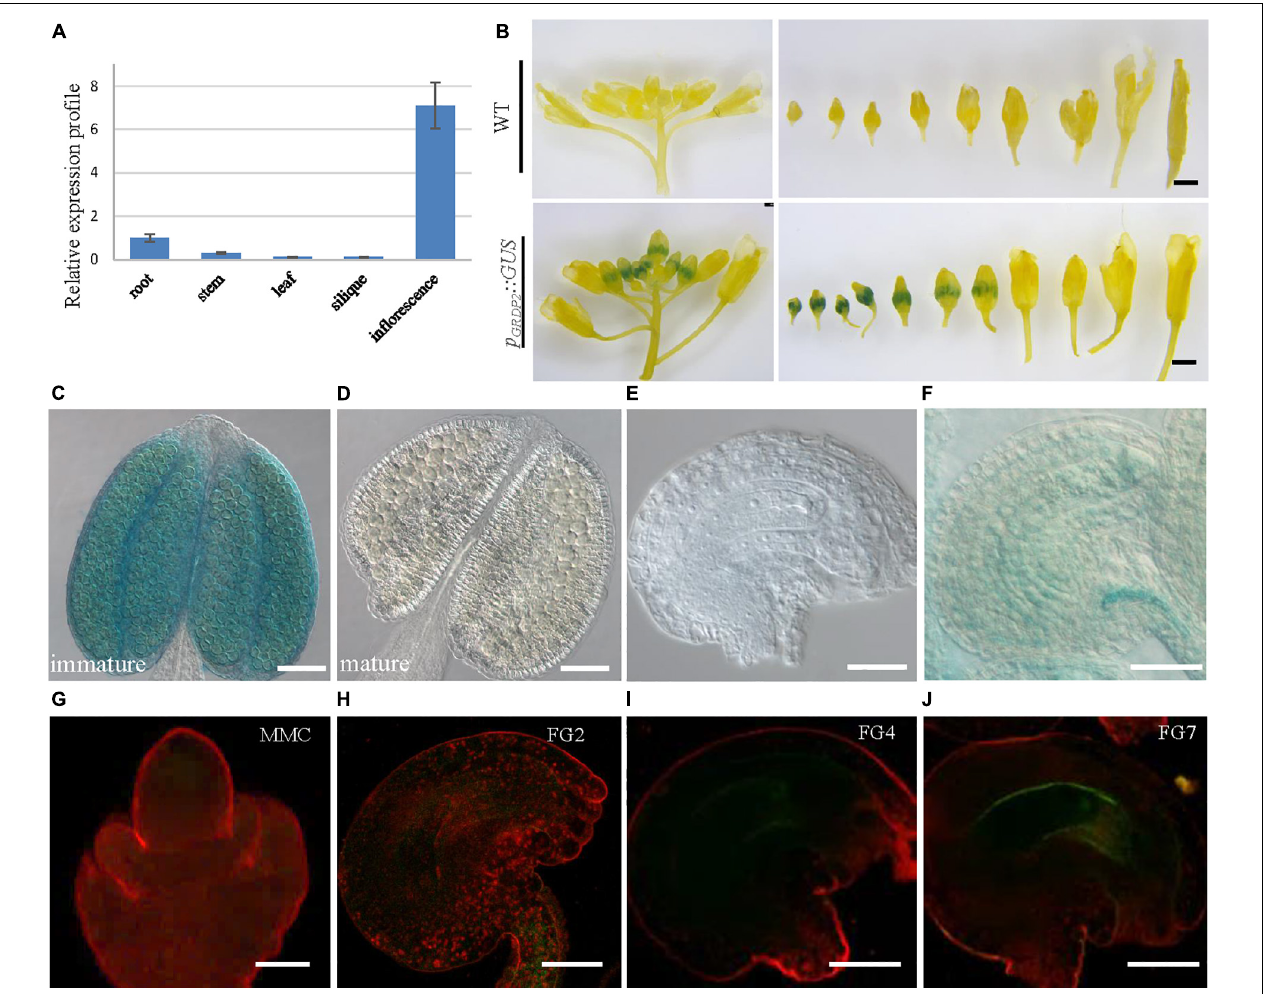
FIGURE 2 | The expression profiles of GRDP2 in Arabidopsis. (A) Real-time PCR to quantify GRDP2 expression levels in different tissue of root, stem, leaf, siliques, and inflorescence. (B) pGRDP2:GUS expression pattern in floral buds. Bars = 1 mm. (C,D) pGRDP2:GUS expression pattern in anthers. Bars = 50 µ m. (E,F) pGRDP2:GUS expression pattern in ovules. Bars = 20 µ m. (G–J) pGRDP2:GFP expression pattern in different ovule development stages. The developmental stages of the ovules are indicated at the top right corner of each panel. Bars = 20 µ